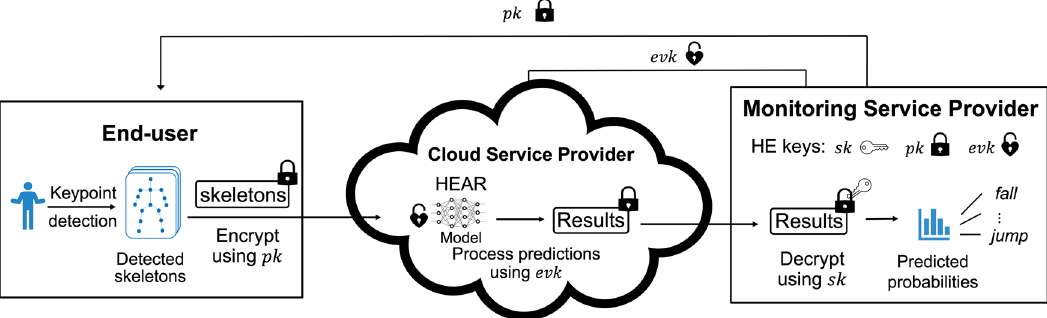
Fig. 1 | A work fl ow of our cloud-based action recognition protocol. At the beginning of the protocol, the monitoring service provider generates the crypto- graphic keys: (i) the secret key sk is used for decryption of ciphertexts; (ii)